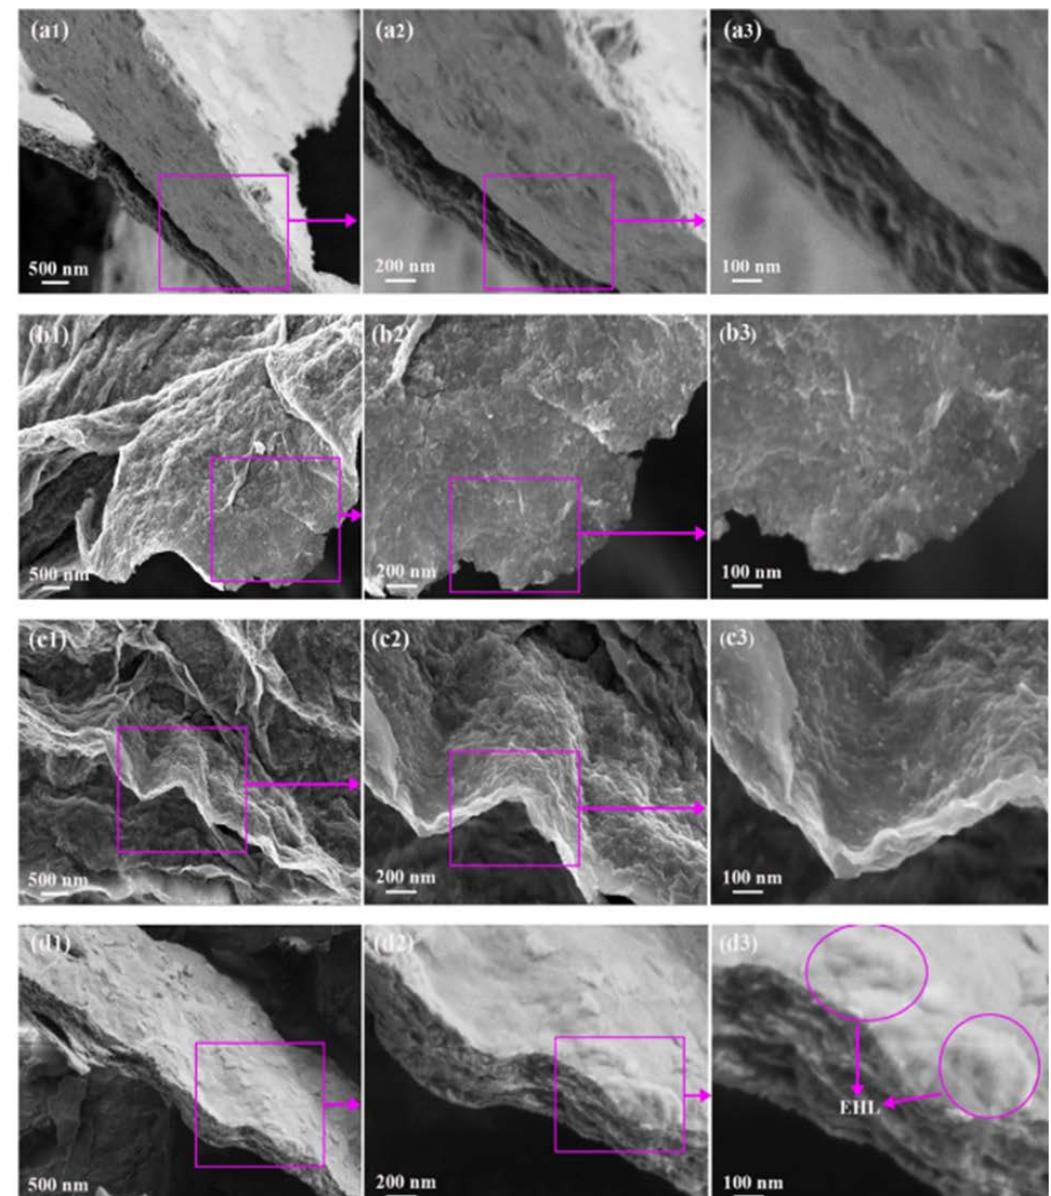
Figure 4. Surface morphologies of ( a1 , a2 , a3 ) MXene sheets, ( b1 , b2 , b3 ) MXene sheets–chitosan, ( c1 , c2 , c3 ) MXene sheets–lignosulfonate, and ( d1 , d2 , d3 ) MXene sheets–enzymatic hydrolysis lignin. Reproduced with permission from [50] . Copyright 2020 Elsevier.